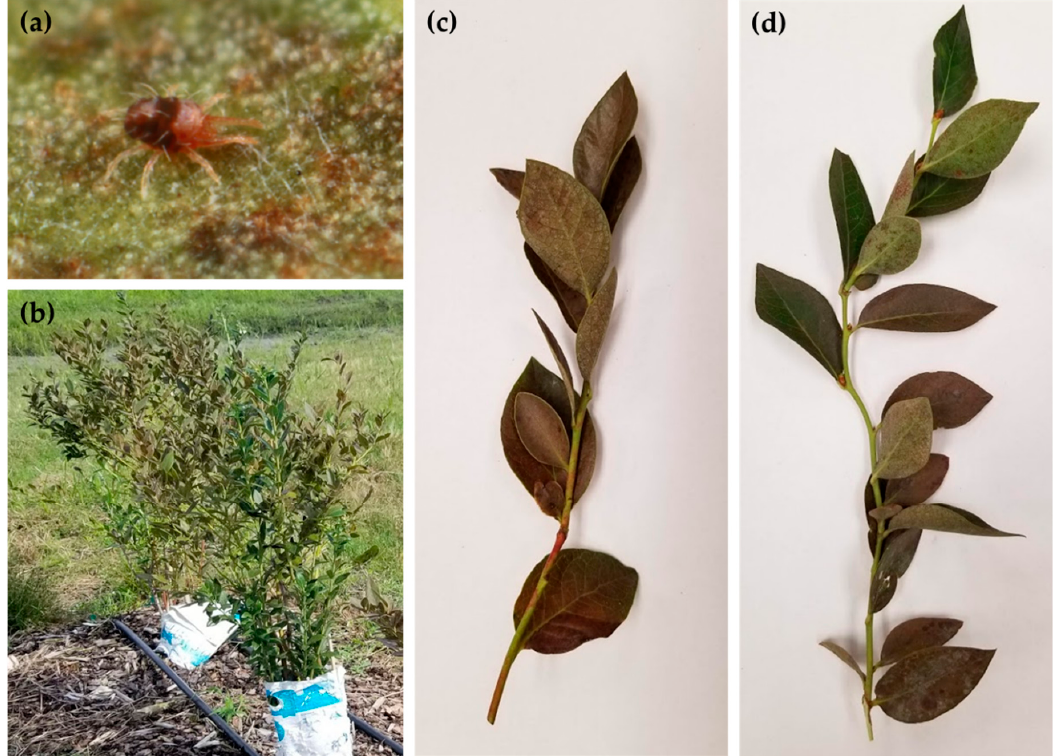
Figure 1. Oligonychus ilicis female on the lower side of a blueberry leaf ( a ), blueberry bushes with bronzing symptoms ( b ), blueberry leaves showing intense bronzing and accumulation of sheds on the lower side of the leaves ( c – d ). Photographs by Lyle Buss ( a ) and Lorena Lopez ( b–c ).